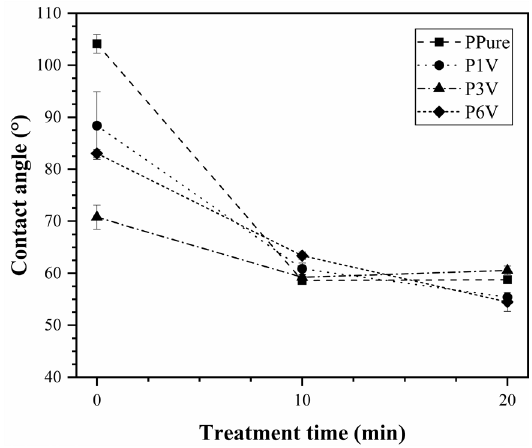
Figure 2. The contact angle of flat films treated according to C